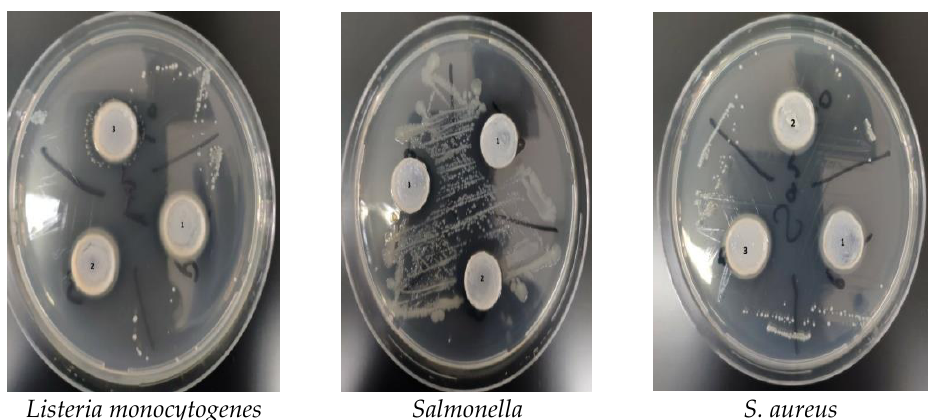
Figure 3. The inhibition zones of CS 1 (1), CS 2 (2) , and CS 3 (3) silver nanofilms against to Listeria monocytogenes, Salmonella and S. aureus, respectively . Table 2. The inhibition zones of silver nanofilms (mm 2 ).